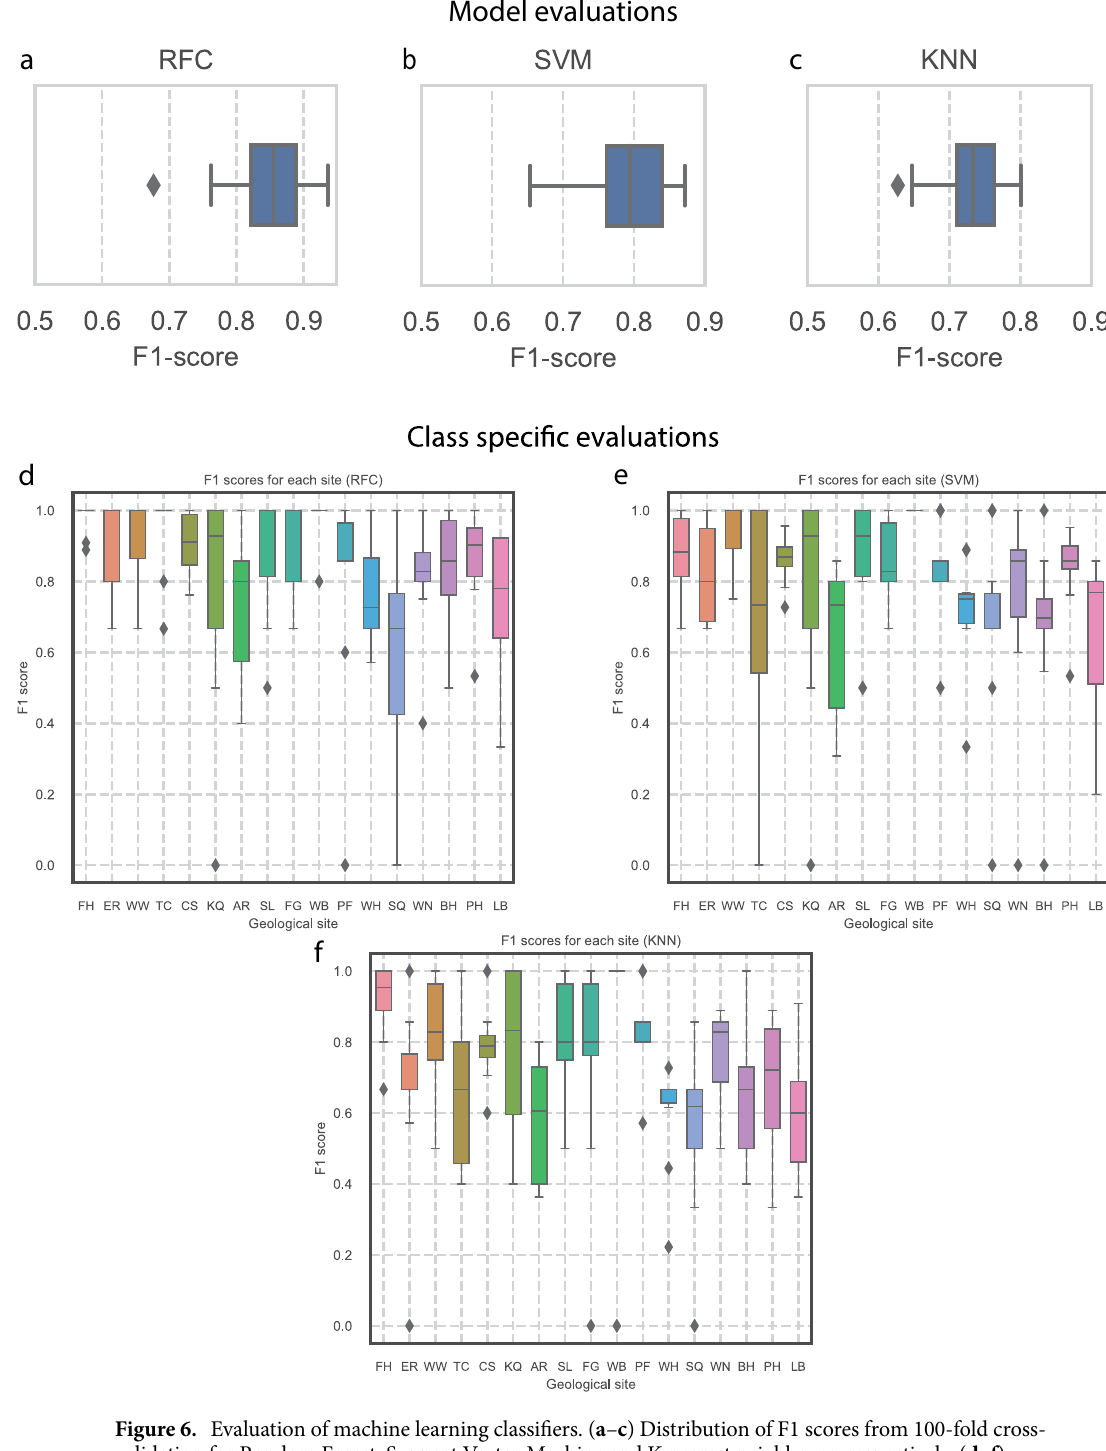
Figure 6. Evaluation of machine learning classifiers. ( a – c ) Distribution of F1 scores from 100-fold cross- validation for Random Forest, Support Vector Machine and K nearest neighbours, respectively. ( d – f ) Distribution of F1-scores for each source for Random Forest, Support Vector Machine and K nearest neighbours,